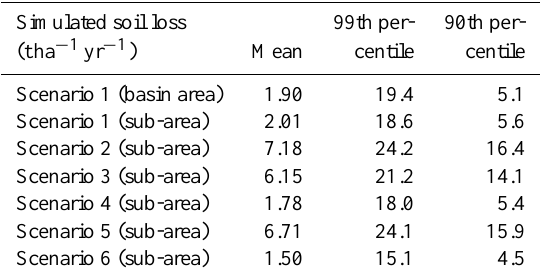
Table 4. Simulated soil loss corresponding to the six studied sce- narios. Erosion in natural conditions (scenario 1) has been reported both for Rio Mannu Basin and for the sub-area subjected to treat- ments in scenarios 2–6. Soil losses corresponding to basin sub-area under treatments are reported in scenarios